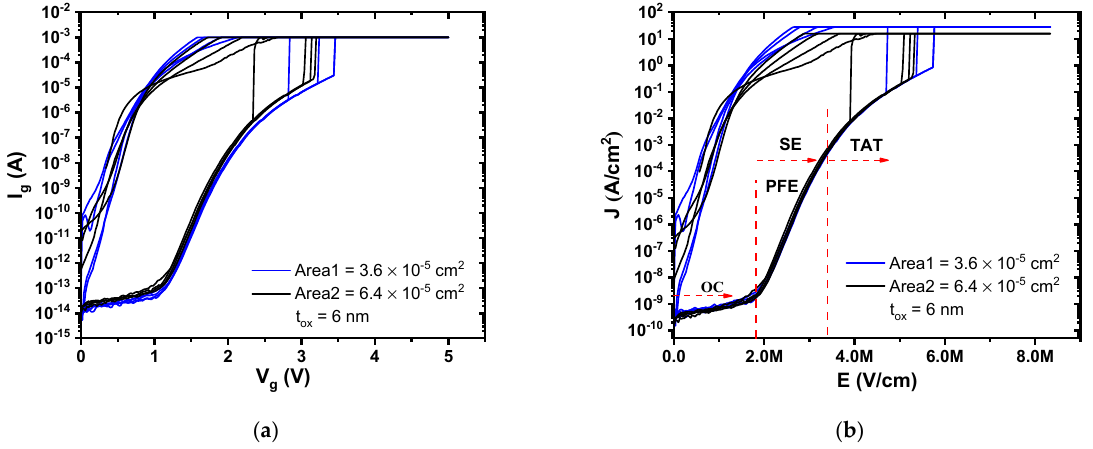
Figure 2. ( a ) Gate current–gate voltage ( I g - V g ) measurements of MIS devices, and ( b ) current density- electric field ( J - E ) representation.